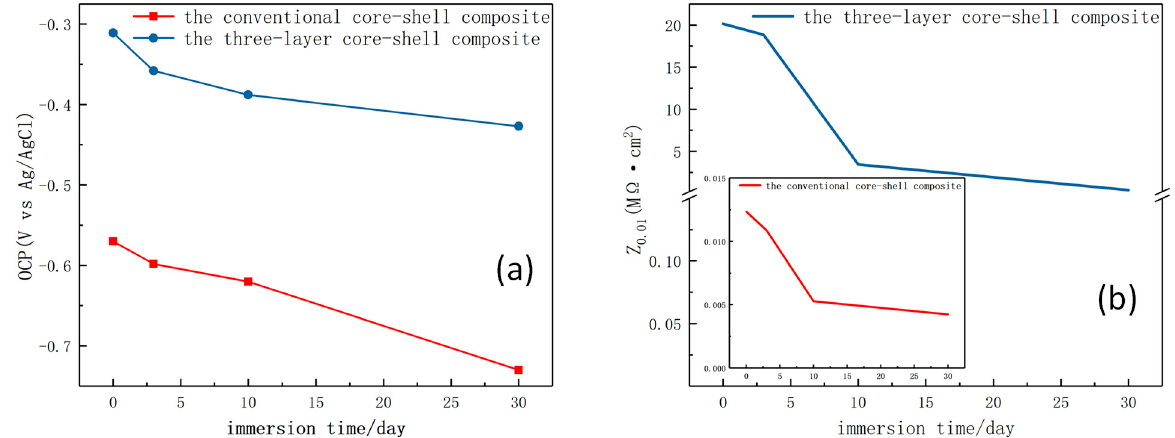
Figure 8. ( a ) Open circuit potential (OCP) and ( b ) impedance modulus (|Z| 0.01Hz ) at frequency of 0.01 Hz at different time intervals of immersion.